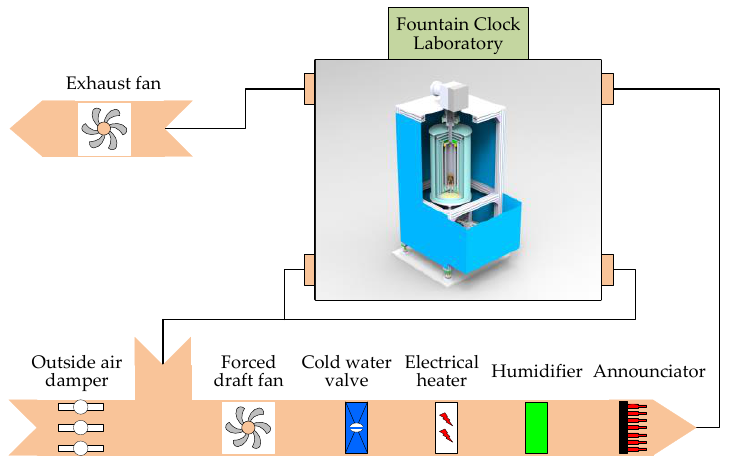
Figure 2. Temperature annunciator.